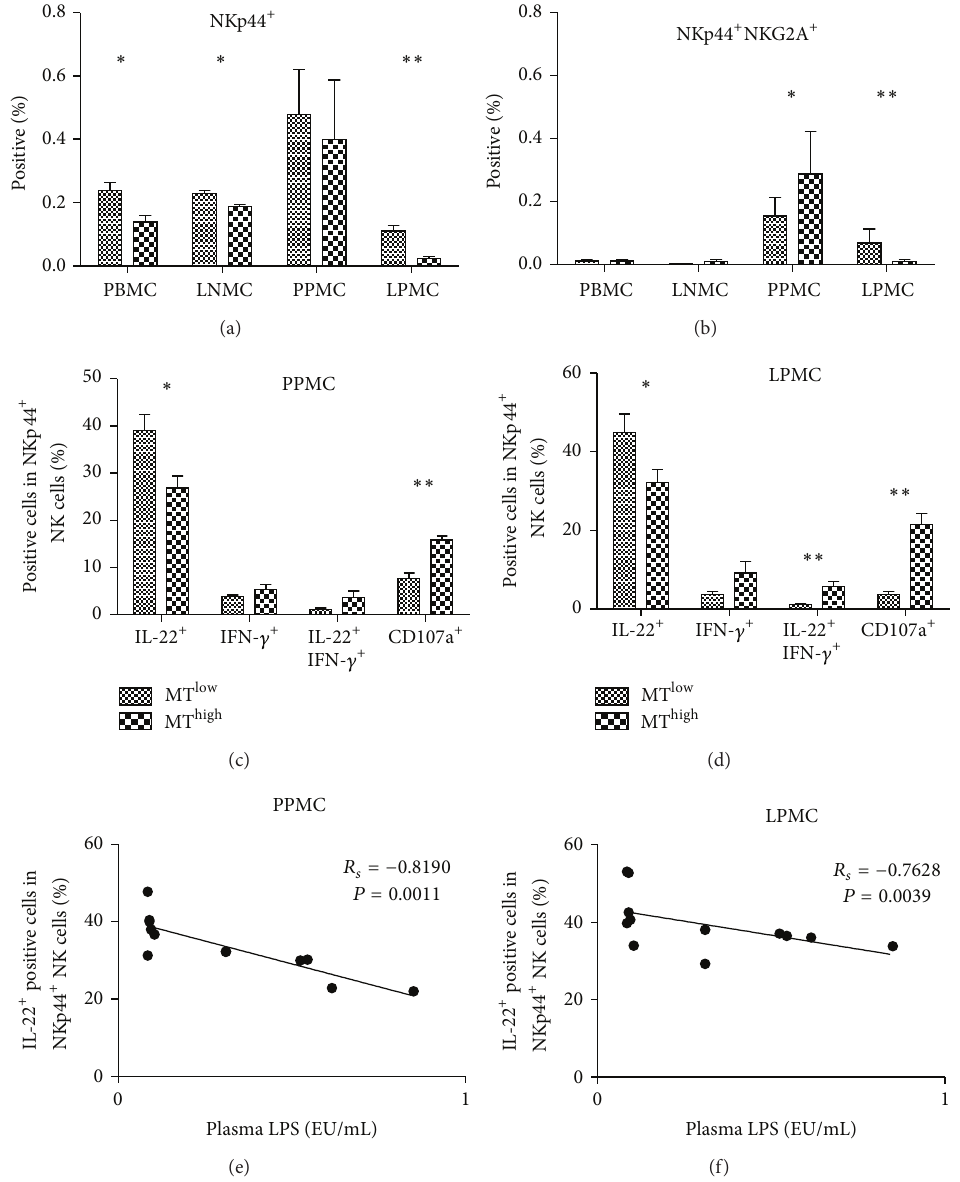
Figure 4: Percentage and function of natural killer (NK)p44 + cell subsets are altered in the microbial translocation ( MT ) high and MT low groups. Frequency of (a) NKp44 + NK cells and (b) NKG2A + NKp44 + NK cells in peripheral and mucosal tissues from the MT low and MT high groups. The expressions of IL-22, IFN- 𝛾 , and CD107a of NKp44 + NK cells were compared between the MT low and MT high groups in (c) Peyer’s patches mononuclear cells (PPMCs) and (d) lamina propria mononuclear cells (LPMCs). The column bar indicates the mean of the ratio of target cells (mononuclear cells in (a) and (b); NKp44 + NK cells in (c) and (d)). Error bars and individual standard deviations (SD) are shown. Spearman correlation test showed that the number of IL-22 + NKp44 + NK cells in PPMCs and LMPCs correlated well with plasma lipopolysaccharide (LPS) levels. ∗ 𝑃 ≤ 0.05 and ∗∗ 𝑃 ≤ 0.01 as calculated by two-sided nonparametric Mann-Whitney 𝑈